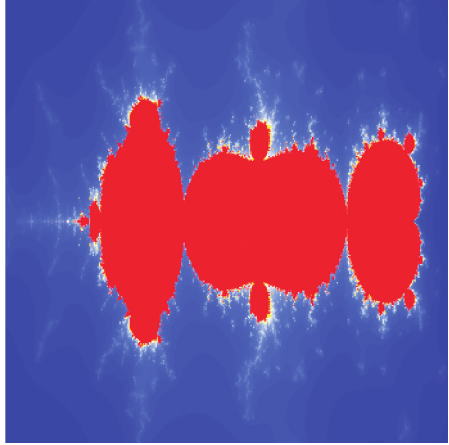
Figure 13: Quadratic Mandelbrot set in JSOmhh.